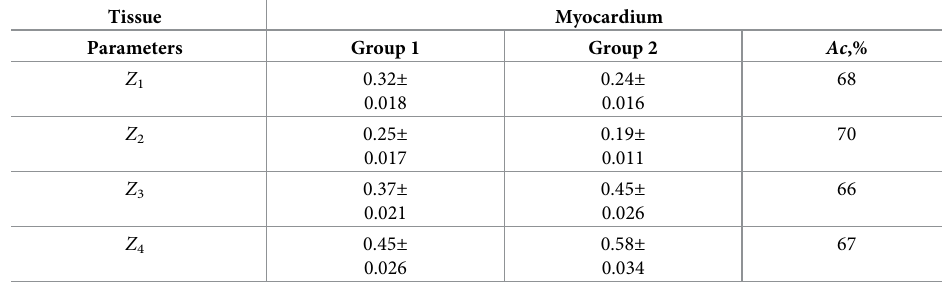
Table 1. Parameters of the statistical analysis of polarization images of the polycrystalline structure of myocardium.